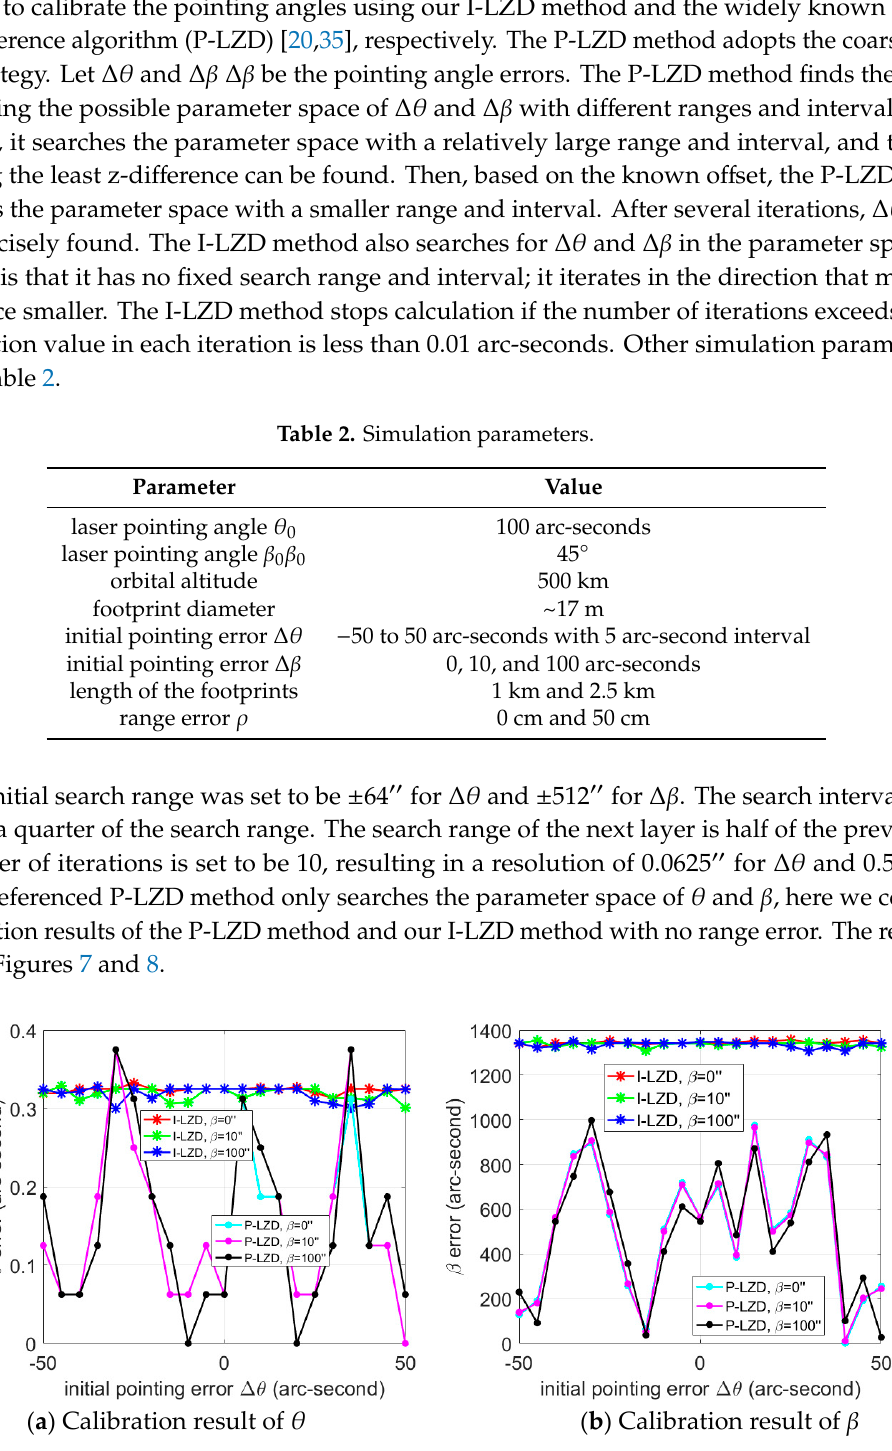
Figure 7. Calibration results of the pyramid least z-difference algorithm (P-LZD) method and the iterative least z-difference (I-LZD) method based on different initial errors of θ and β ; 1 km length tracks were used. The range error ∆ ρ was set to be zero.